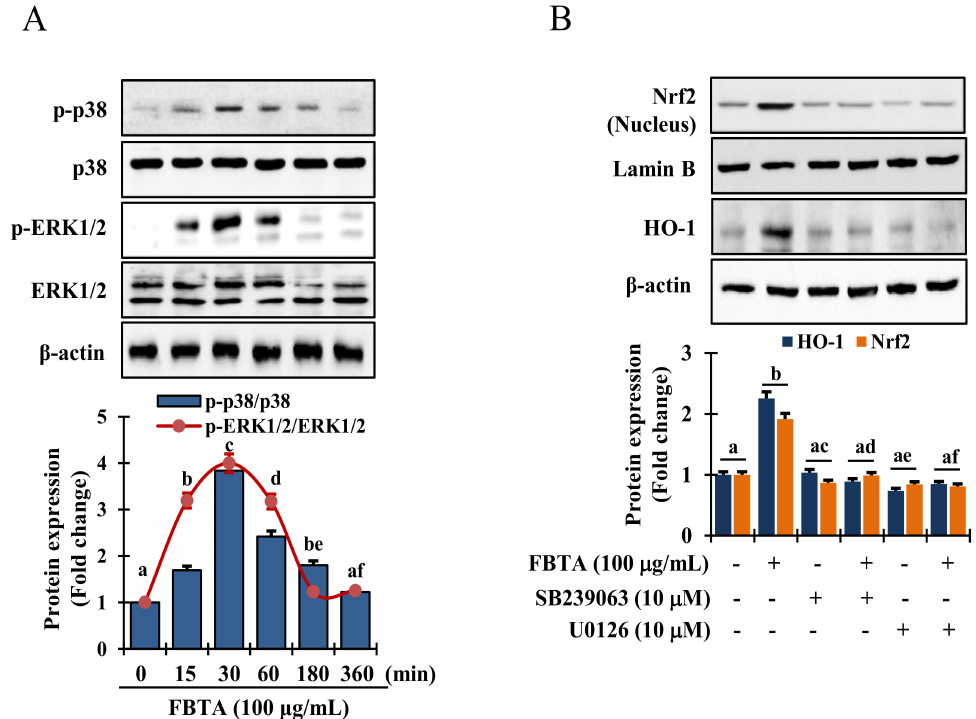
Figure 6. FBTA activates the mitogen-activated protein kinases (MAPKs) signaling pathway. ( A ) HaCaTs were treated with FBTA (100 µ g/mL) at the indicated time point and the activated and non-activated forms of extracellular signal-regulated kinase 1 and 2 (ERK 1/2), and p38 were identified by immunoblotting assay. The different letters of each column indicate significance ( p < 0.05). ( B ) Cells were treated with specific inhibitor U0126 and SB239063 in the presence and absence of FBTA (f.c. 100 µ g/mL). Nrf2 and HO-1 expressions were analyzed by immunoblotting. Densitometric analysis was carried out to quantify the band intensity by β -actin normalization. The different letters of each column indicate significance ( p < 0.05). Different letters (a, b, c, d, ac, ad, ae, af, be) are denoted as the statistical